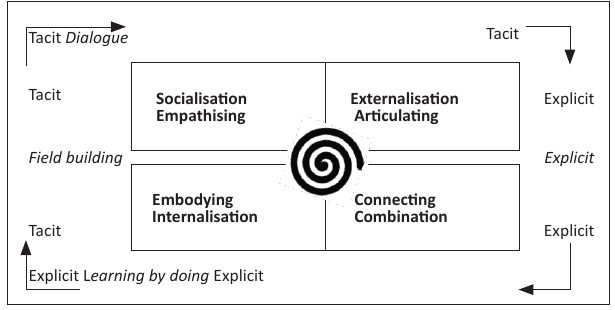
FIGURE 2: The knowledge